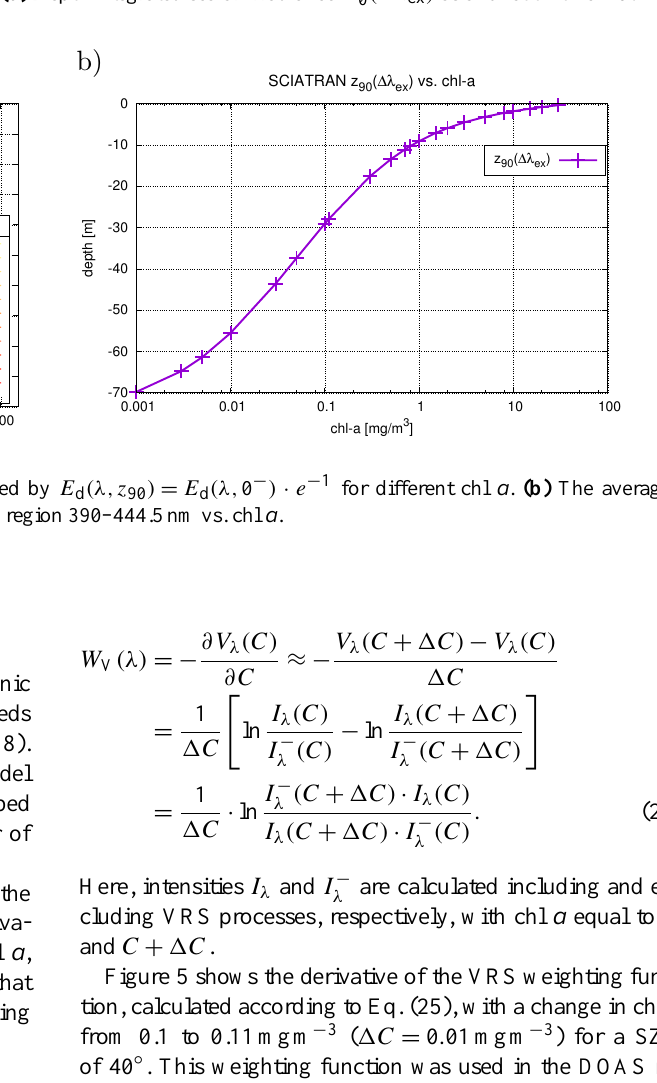
Figure 2. (a) Scalar irradiance E 0 (z,(cid:49)λ ex ) of the subsurface light field, integrated over the VRS excitation wavelength region (cid:49)λ ex from 390 to 444.5nm, for different chl a and for a fixed SZA of 40 ◦ . (b) Depth integrated scalar irradiance E 0 ((cid:49)λ ex ) as a function of chl a .